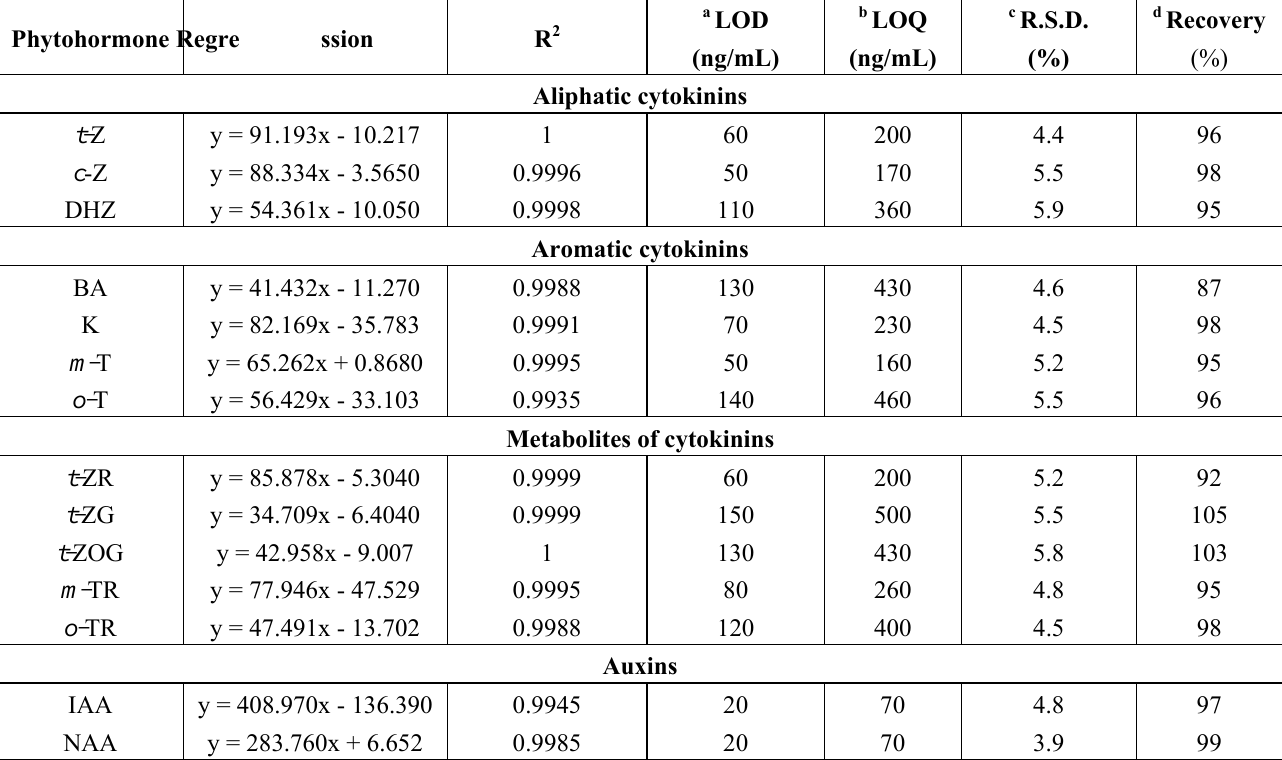
Table 2. Analytical parameters for HPLC-UV determination (n =